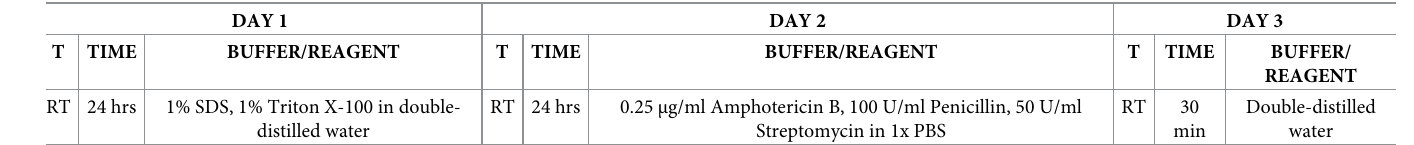
Table 1. Protocol steps scheme.